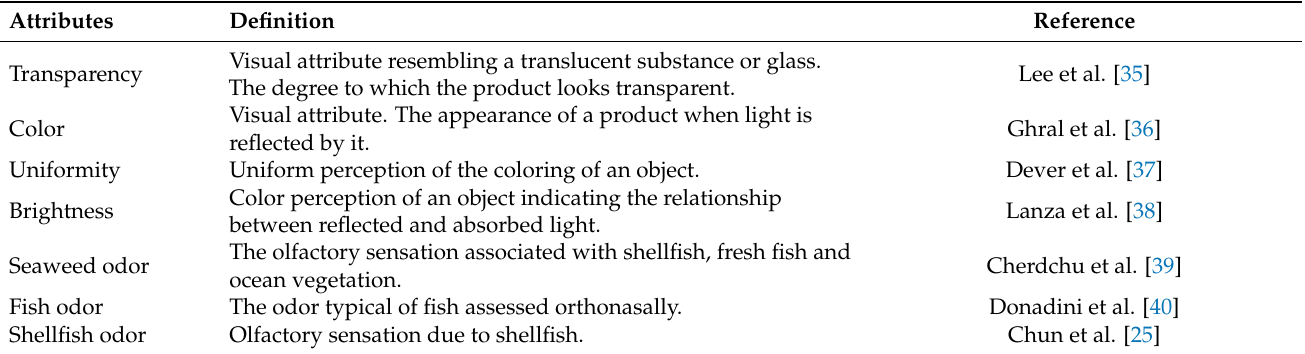
Table 2. Lexicon list developed by sensory